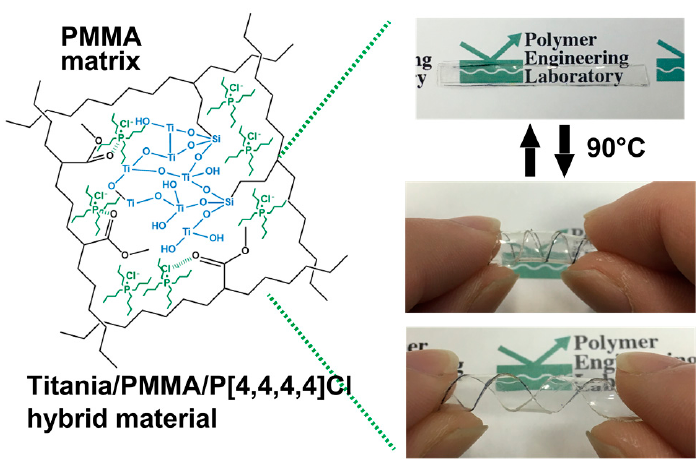
Figure 4. Schematic representation of the hybrid material composed of poly(methyl methacrylate) (PMMA), titania, and tetrabutylphosphonium chloride (TBPC). The transparency, toughness, and shape memory of the PMMA/titania hybrid are improved.